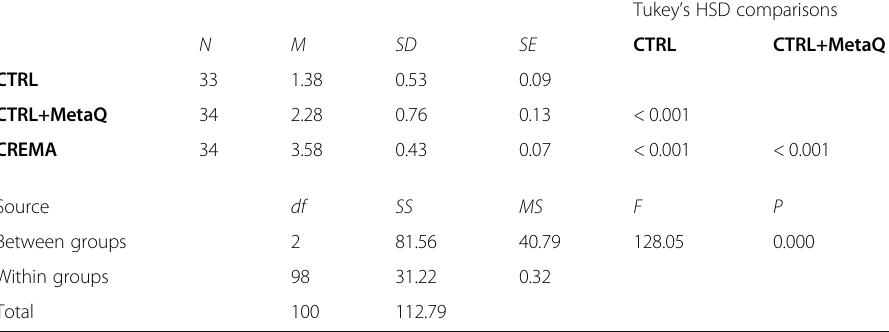
Table 4 ANOVA results and descriptive statistics for Q-L2SRL posttest